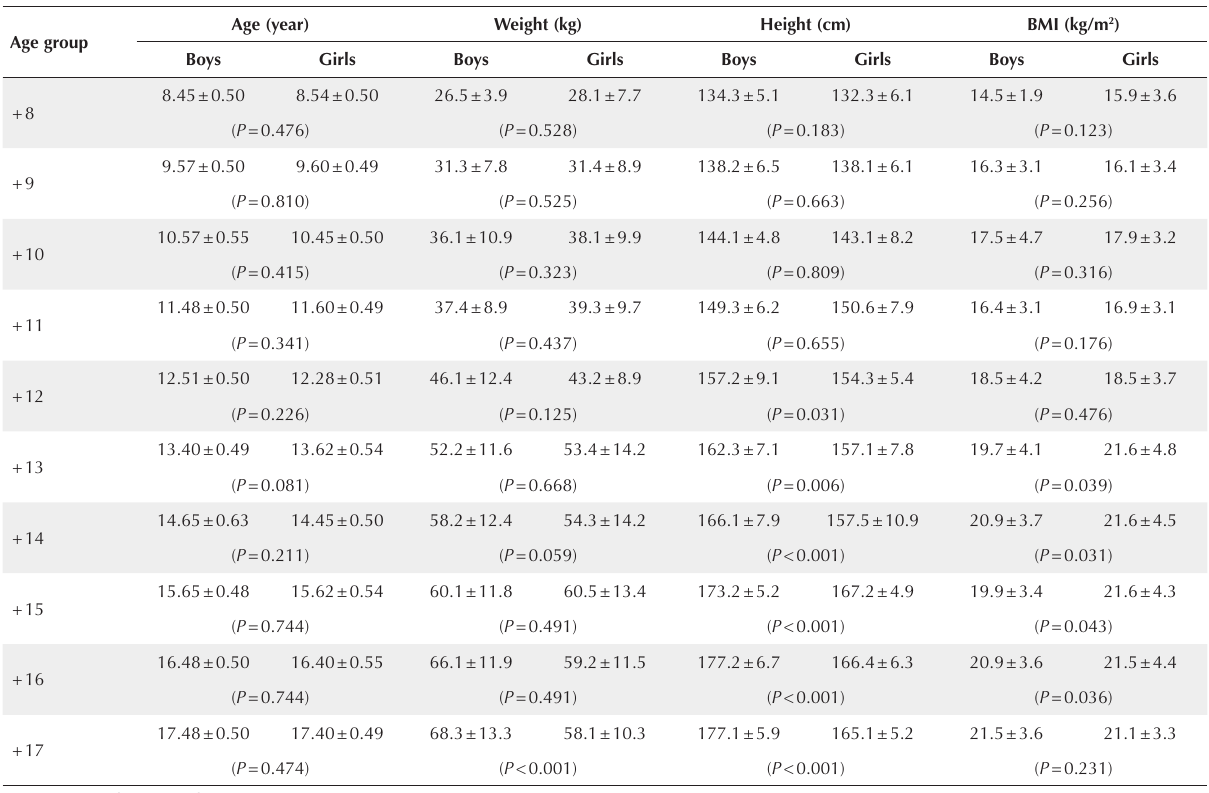
Table 2. Characteristics of school-age children Age group